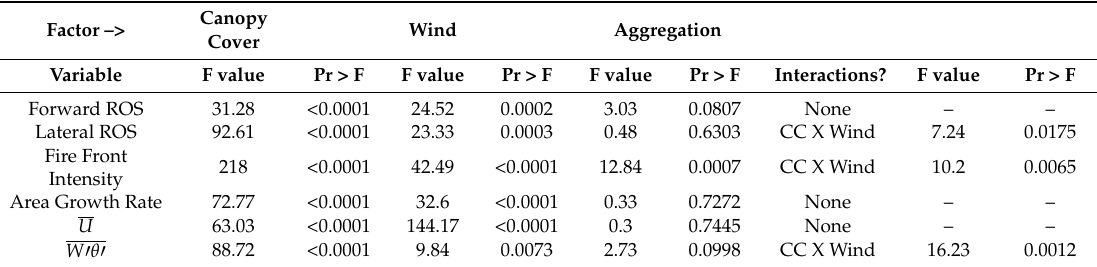
Table 2. Summary of results of statistical analysis using a generalized linear mixed modeling procedure (PROC GLIMMIX) with the SAS statistical analysis software. Effects of forest cover, wind and canopy spatial aggregation, as well as possible interaction effects were analyzed.